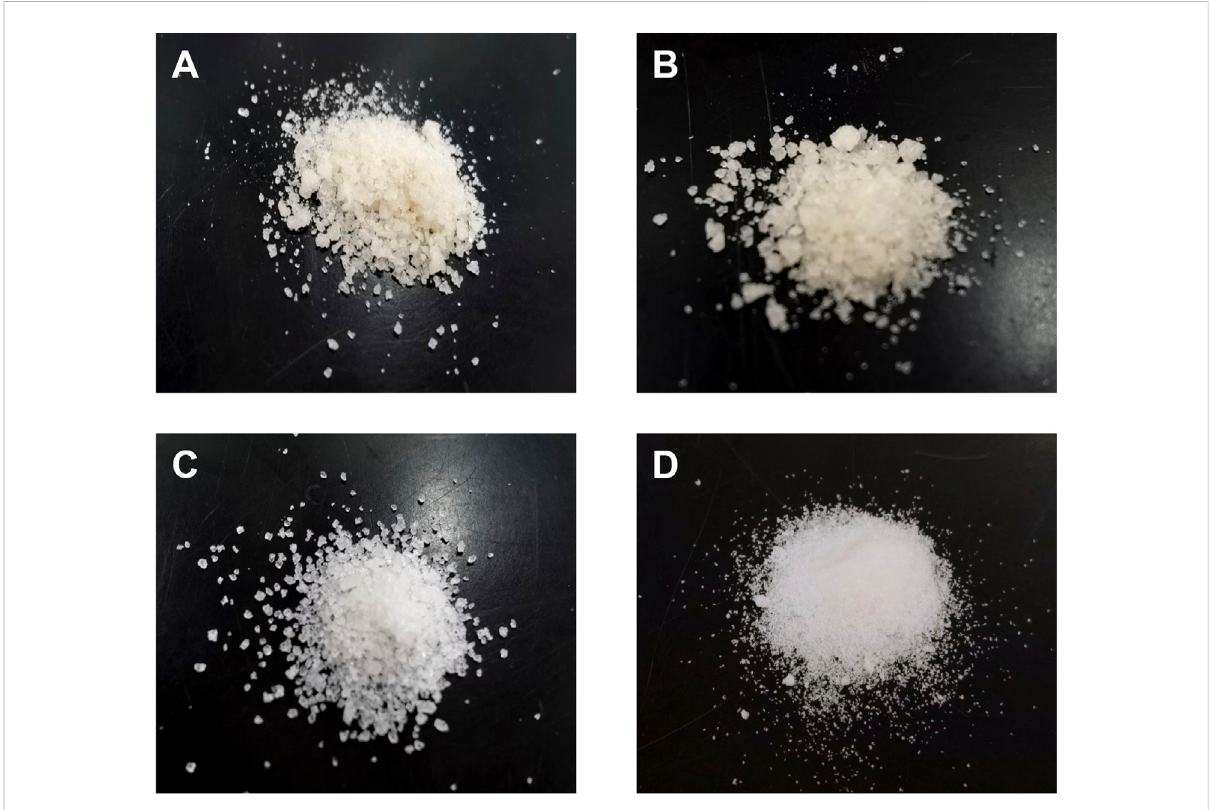
FIGURE 7 Imagesofxylitolcrystalsobtained. (A) Xylitolobtainedbycrystallizationofthefermentationbrothusing50%(v/v)methanolwithacrystallization temperature of 0 ° C; (B) xylitol obtained by crystallization of the fermentation broth using 25% (v/v) methanol with a crystallization temperature of 25 ° C; (C) xylitol obtained by crystallization of the fermentation broth using 50% (v/v) methanol with a crystallization temperature of 25 ° C; (D) xylitol obtained by further secondary